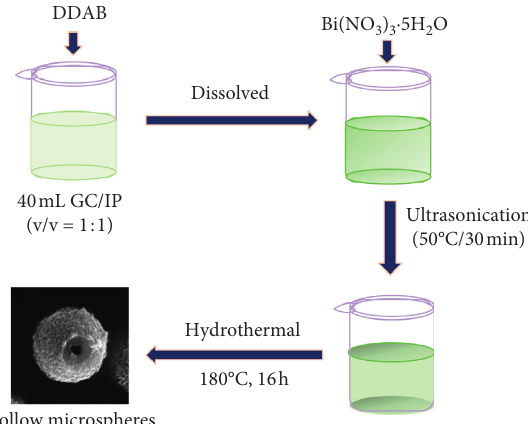
Figure 1: Synthesis flowchart for